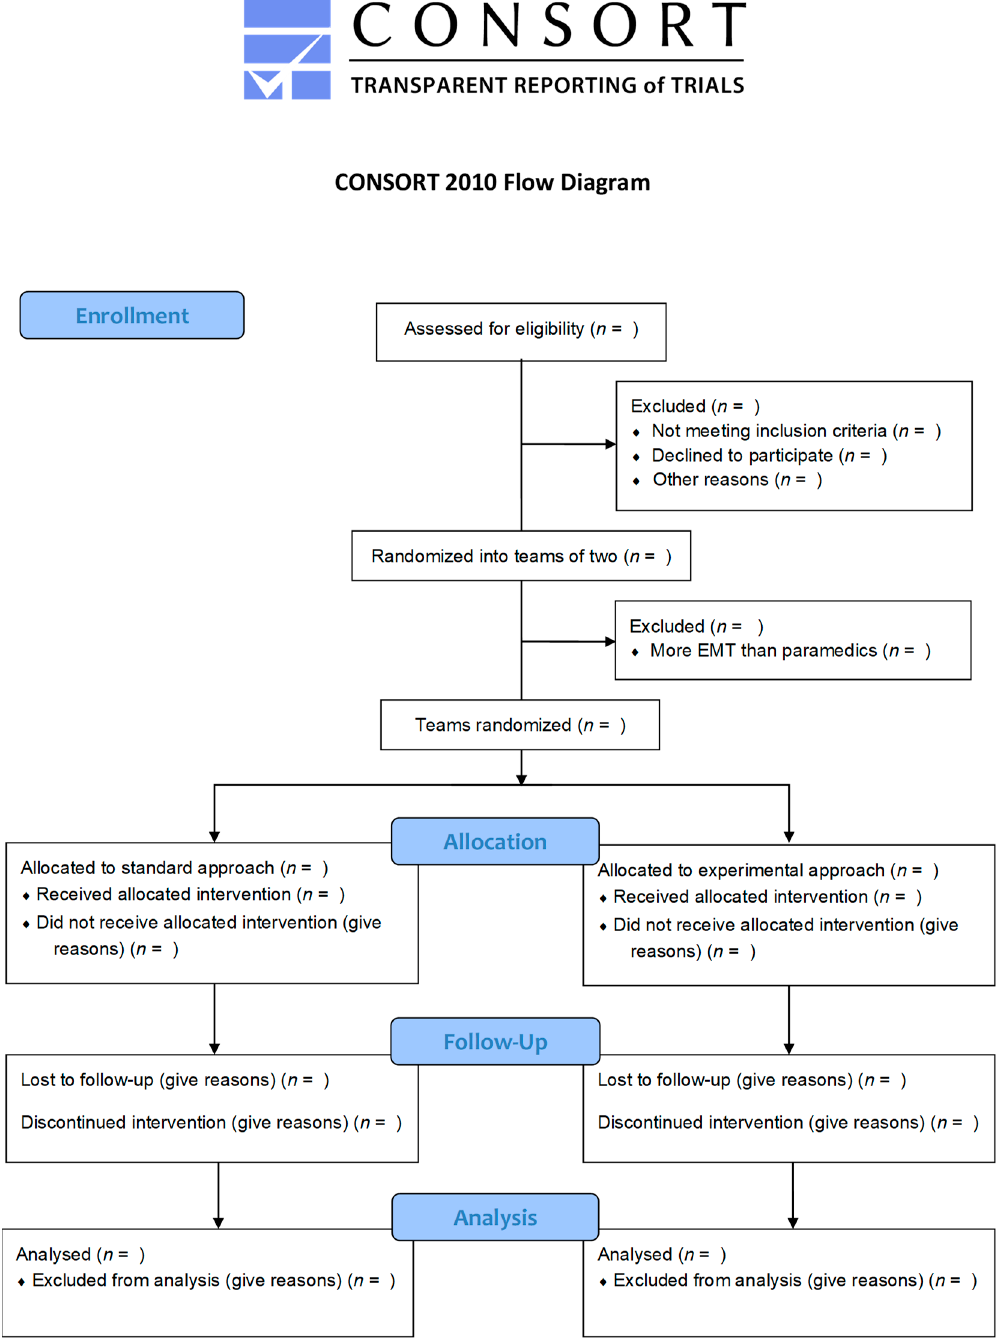
Figure 1. Study flow chart.